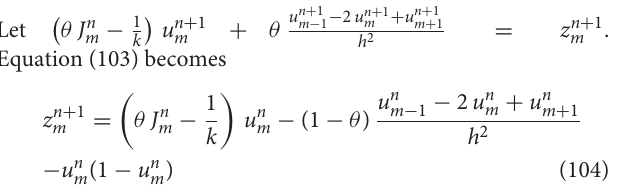
10 4 at time, T max =